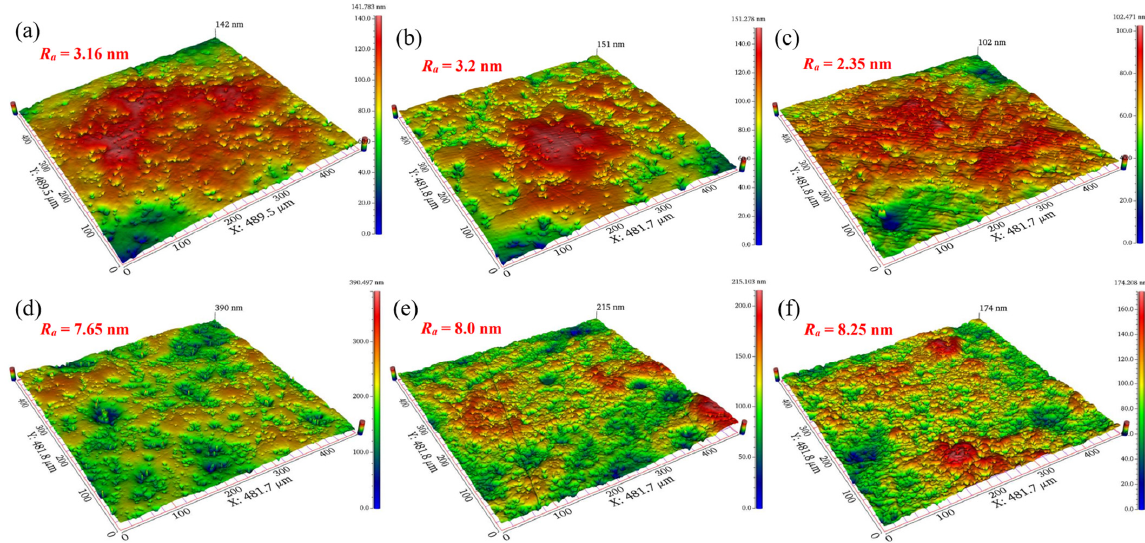
Figure 6. Surface morphologies of polished tungsten under different pH values: ( a ) pH = 7; ( b ) pH = 8; ( c ) pH = 9; ( d ) pH = 10; ( e ) pH = 11; ( f ) pH = 12.